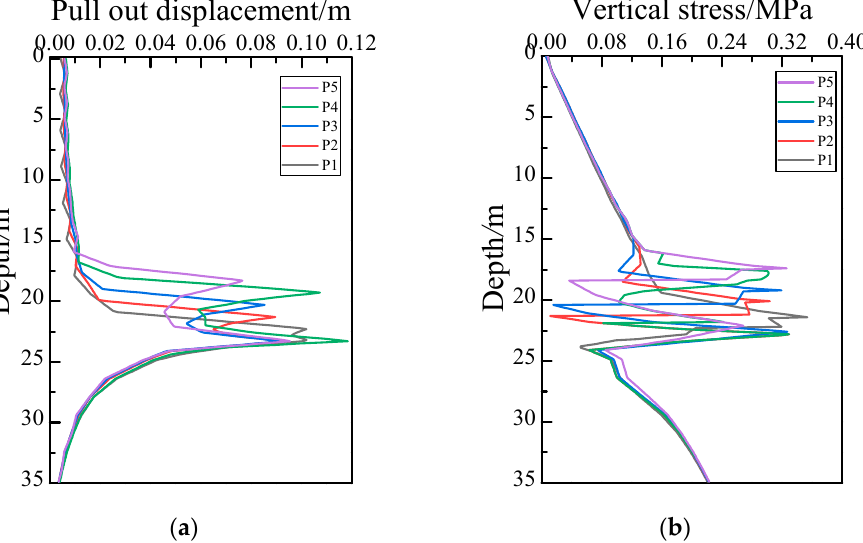
Figure 18. Displacement and stress distribution of soil outside pile along the depth direction. ( a ) P2; ( b ) P3. ( b )